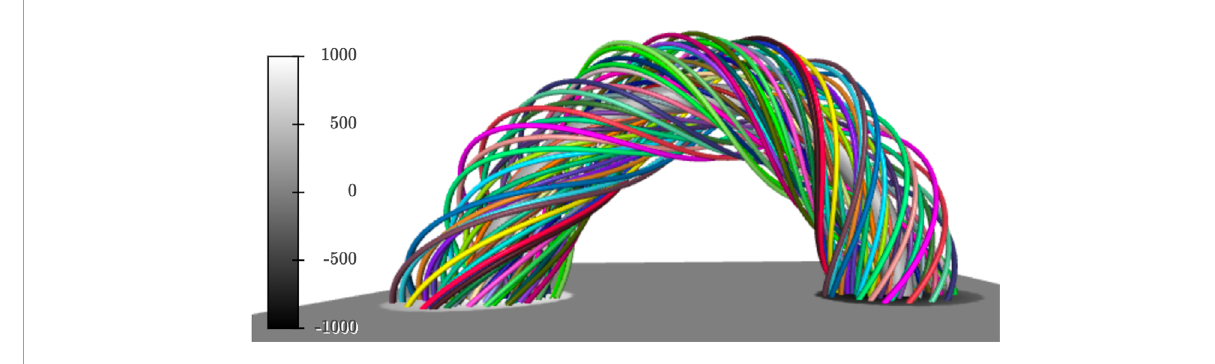
FIGURE 2 Output from the first visualisation of the flux rope. The axis is shown by a thicker grey line while the other field lines are shown by randomly coloured thinner lines. B z from the lower boundary of the domain is also shown.